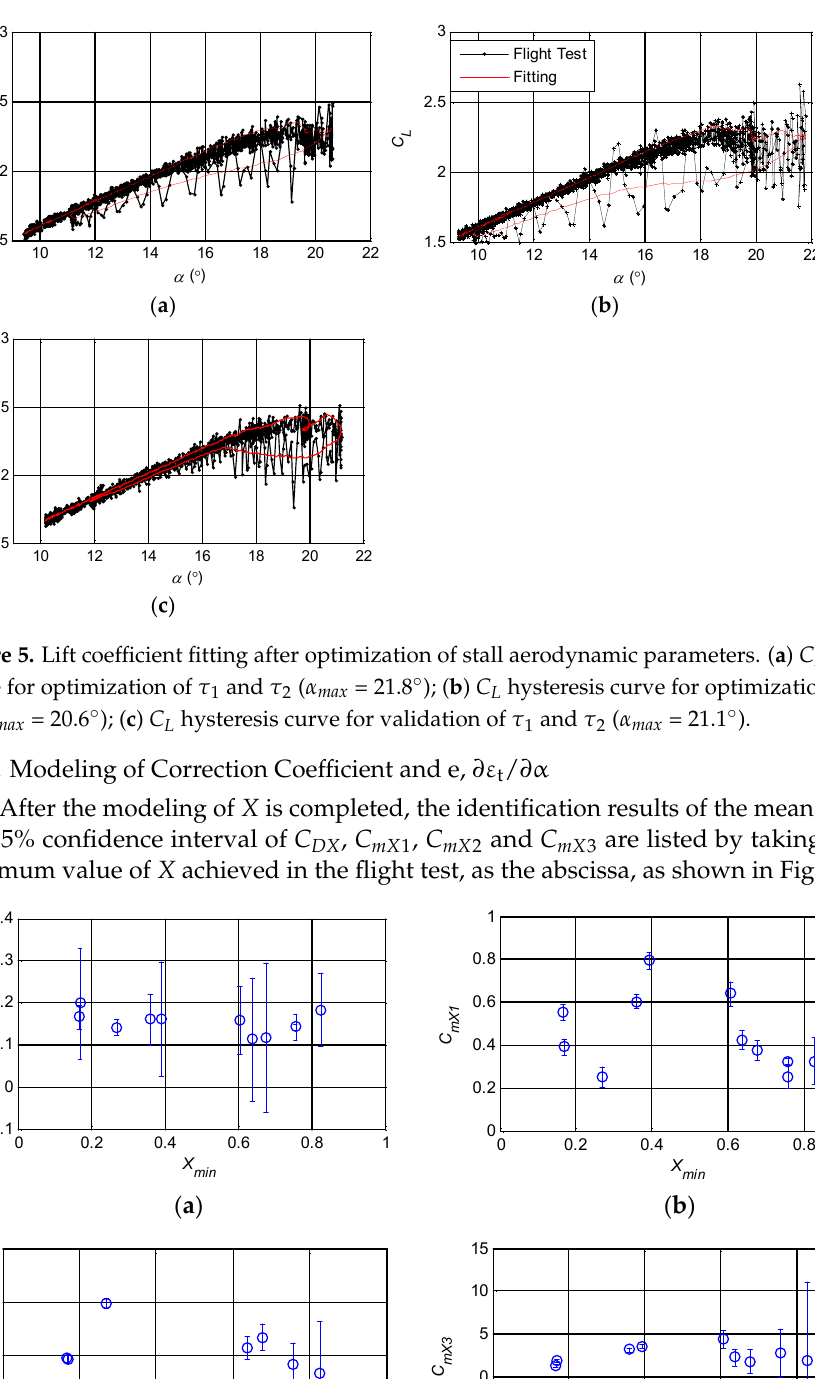
Figure 6. Identification results of correction coefficients. ( a ) C DX − X min ; ( b ) C mX 1 − X min ; ( c ) C mX 2 − X min ; ( d ) C mX 3 − X min .